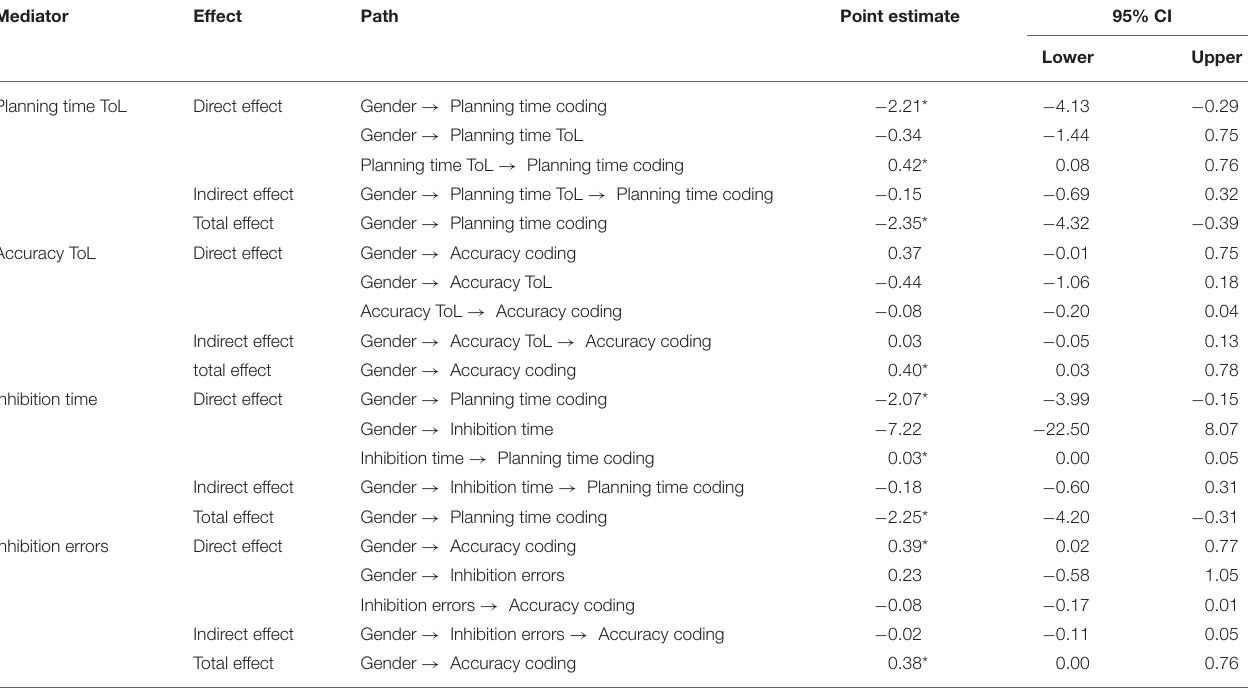
TABLE 5 | Direct, indirect, and total effects of the mediation models.